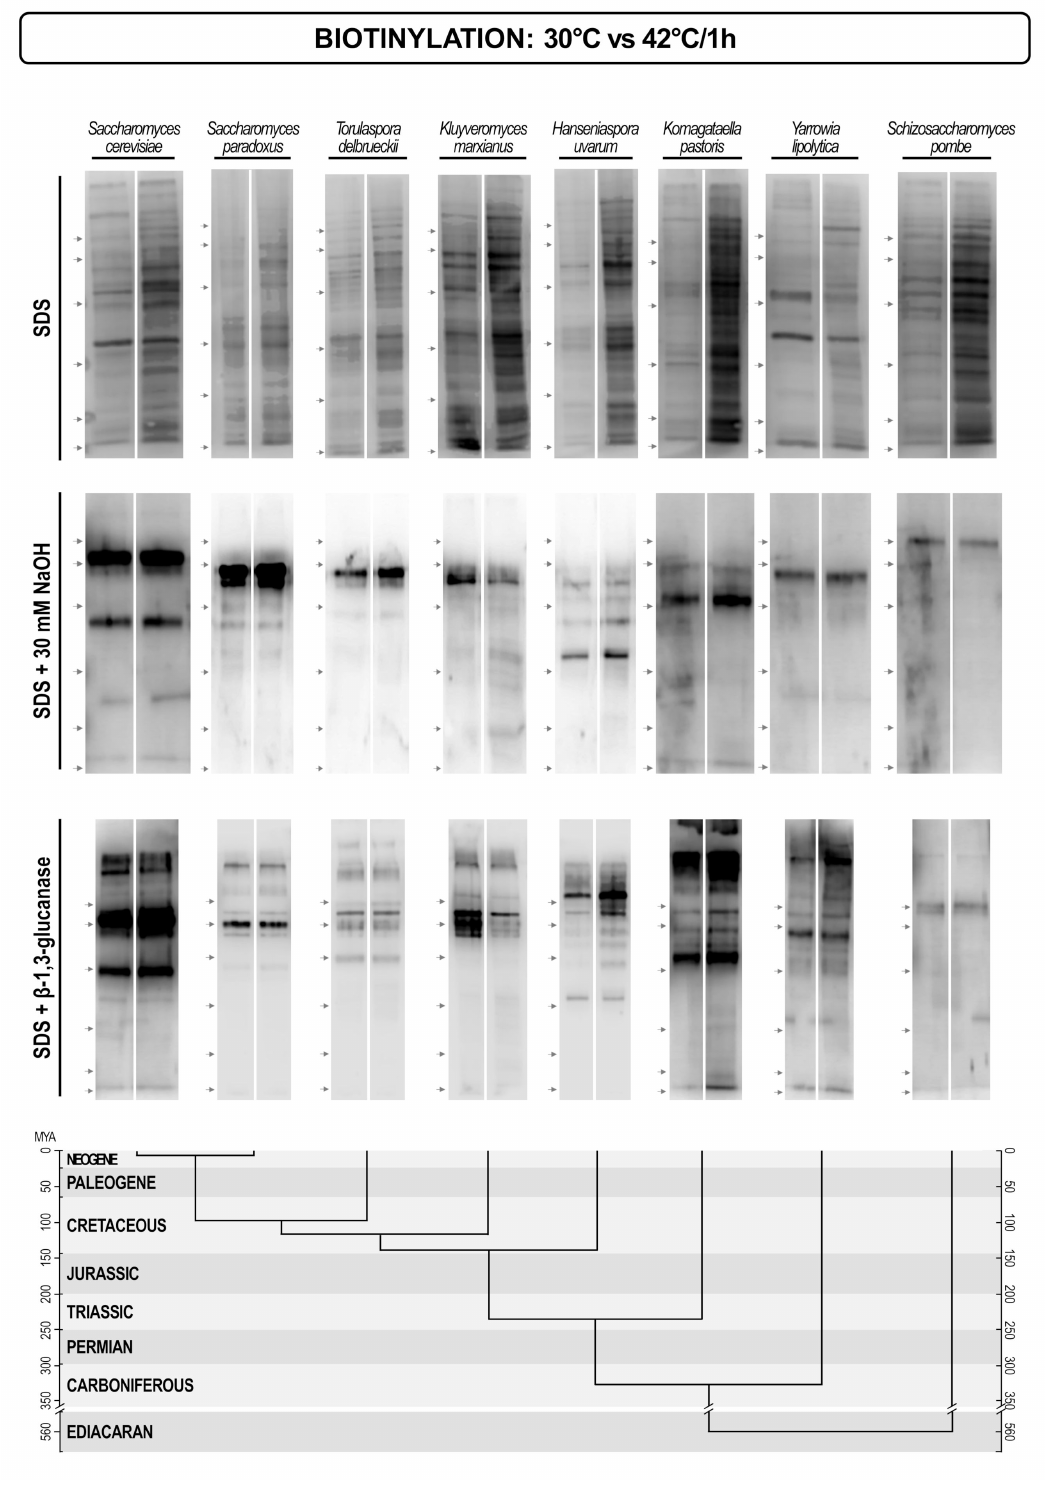
Figure 7. Streptavidin/biotin blots of cell wall proteins of different yeasts extracted by hot SDS (non-covalently attached proteins), alkalis (Pir proteins + Scw4), and glucanases (GPI-anchored proteins). Proteins were extracted from cell walls of yeasts grown at 30 ◦ C (left lane), and then shifted to 42 ◦ C for one hour (right lane). The lower part of the figure presents the evolutionary chronogram of each species. Position of protein molecular mass markers is indicated on the left of each blot with protein sizes identical to those in Figure